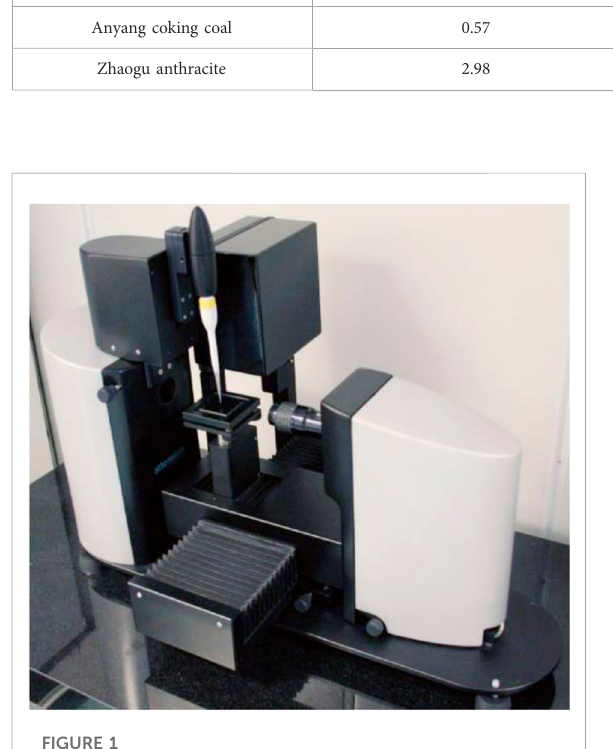
FIGURE 2 Surface roughness of three coal